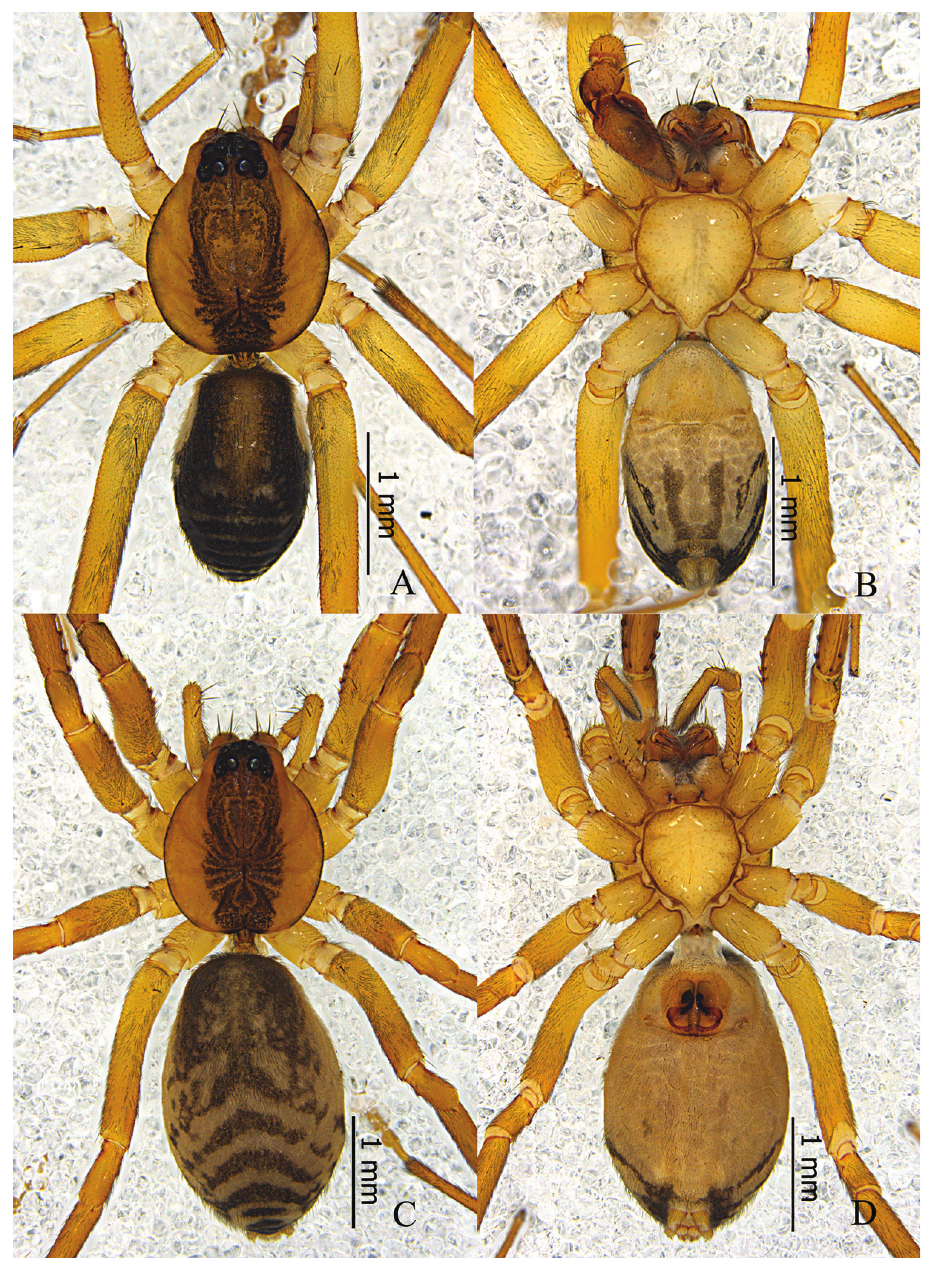
Figure 4. Otacilia yangmingensis sp. n. A male habitus, dorsal view B same, ventral view C Female habitus, dorsal view D same, ventral